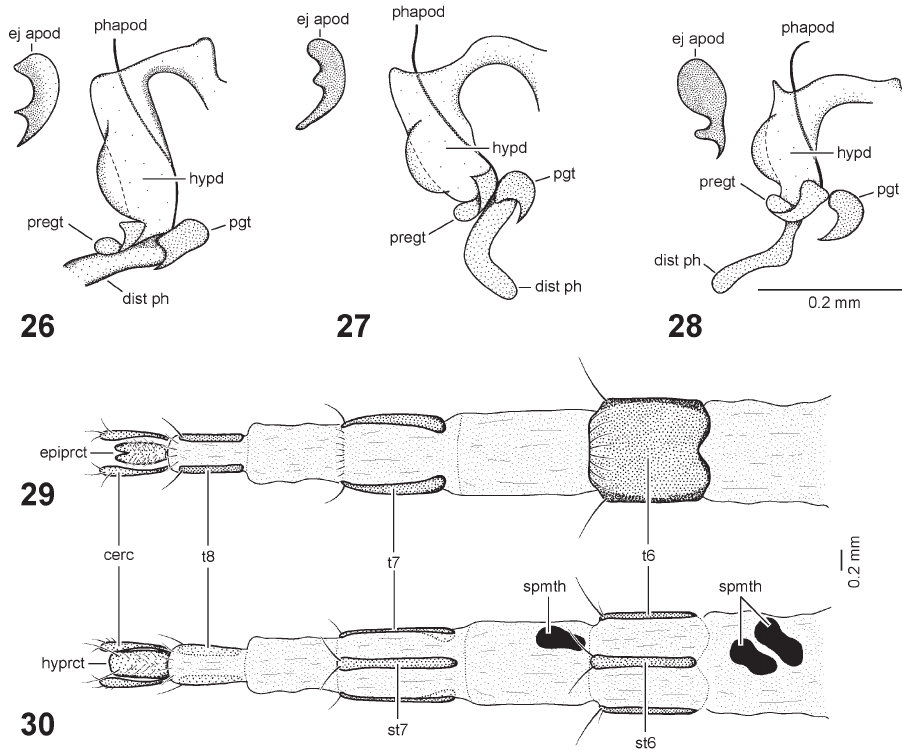
Figures 26–30. Coenosia spp. ♂ , phallic complex 26 C. flagelliseta sp. nov. 27 C. macrotriseta 28 C. globuliseta. Coenosia flagelliseta sp. nov. ♀ , ovipositor 29 dorsal view 30 ventral view. Figs 27, 28 modified (Muller and Miller 2013, figs 9A, B). Abbreviations: cerc – cercus; distph – distiphallus; ej apod – ejacu- latory apodeme; epiprct – epiproct; hypd – hypandrium; hyprct – hypoproct; pgt – postgonite; phapod – phallapodeme; pregt – pregonite; spmth – spermathecal; st – sternite; t –